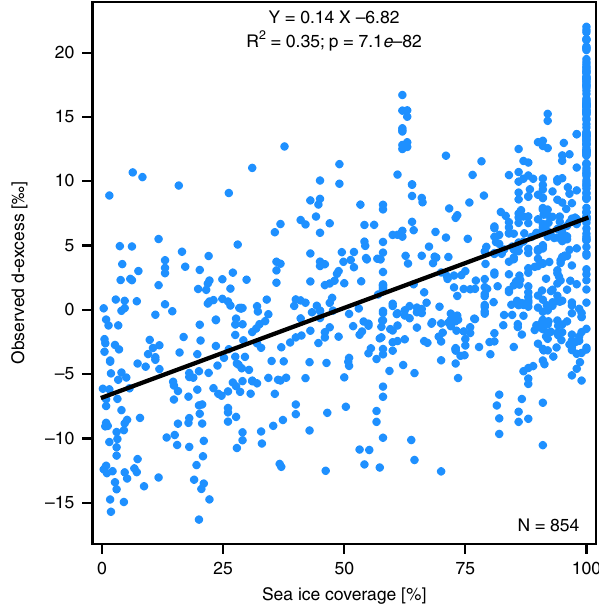
Fig. 6 Sensitivity of the deuterium excess in vapour with respect to different sea ice coverage conditions. Relation between d-excess measurements and sea ice coverage around Polarstern for the period 29 June 2015 to 30 June 2017 (blue dots). Only d-excess measurements for sea ice coverages higher than 0% are considered. A linear regression is displayed in black. All plots are based on data with a 6-h temporal